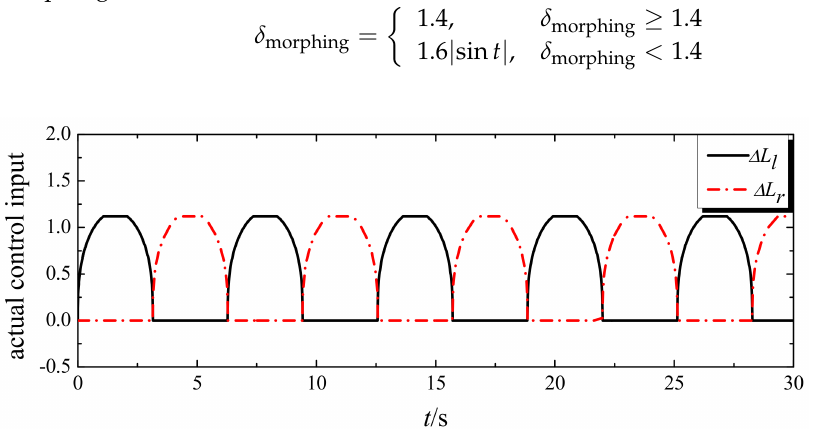
Figure 14. The actual control input due to the morphing